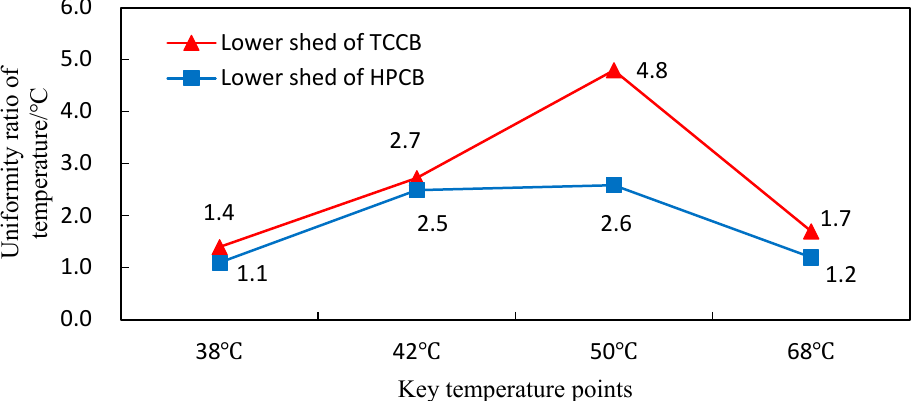
Figure 3. The uniformity ratio of upper shed temperature in TCCB and HPCB modes along the horizontal direction.